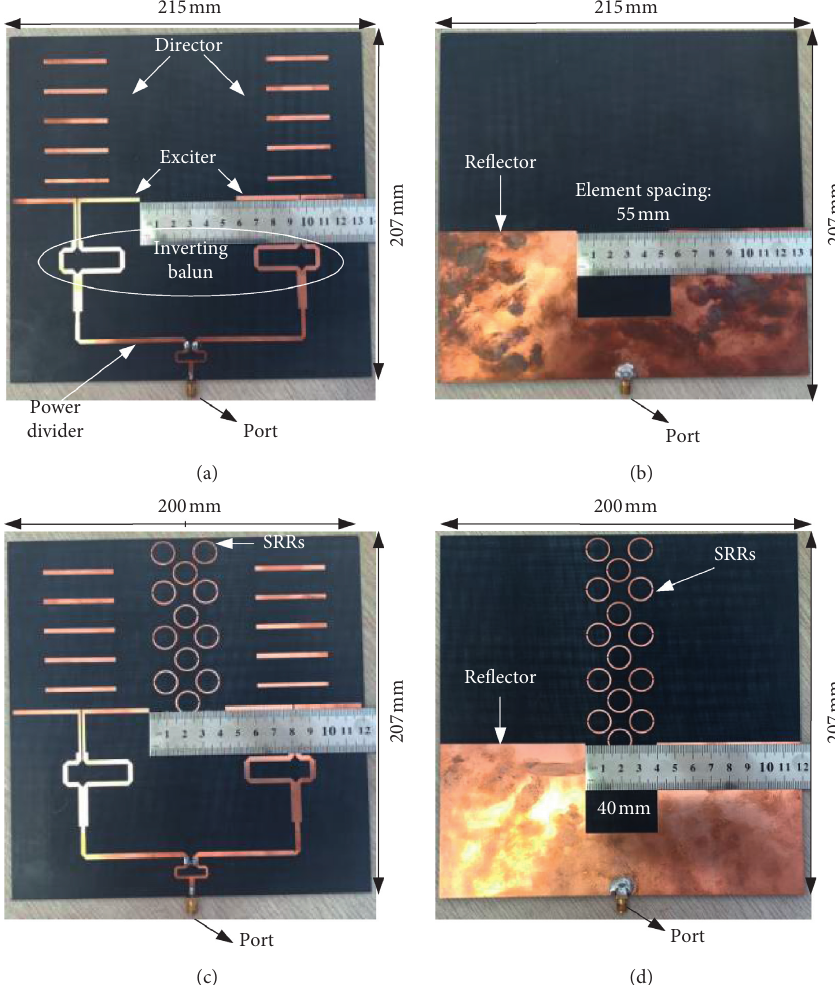
Figure 16: Prototype of the quasi-Yagi antenna array. (a) Top view of the reference array (55mm). (b) Bottom view of the reference array (55mm). (c) Top view of the array with SRRs (40mm). (d) Bottom view of the array with SRRs (40mm).